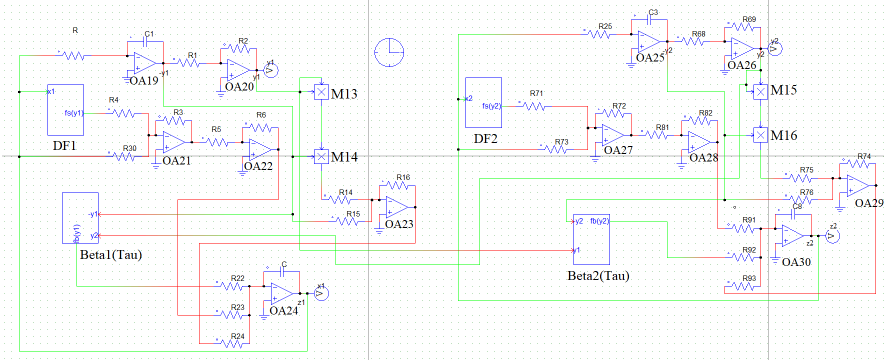
Figure 17. The analog circuit diagram of the considered mechanical system. The resistance values are: R = R 1 = R 2 = R 3 = R 4 = R 5 = R 6 = R 16 = R 22 = R 23 = R 24 = R 25 = R 68 = R 69 = R 71 = R 72 = R 74 = R 81 = R 82 = R 91 = R 92 = R 93 = 100 k Ω , R 30 = 576.04 k Ω , R 73 = 482.62 k Ω , R 14 = 2.50 k Ω , R 15 = 18.26 k Ω , R 75 = 2.1 k Ω , R 76 = 14.91 k Ω . The capacitor values: C = C 1 = C 3 = C 8 = 1